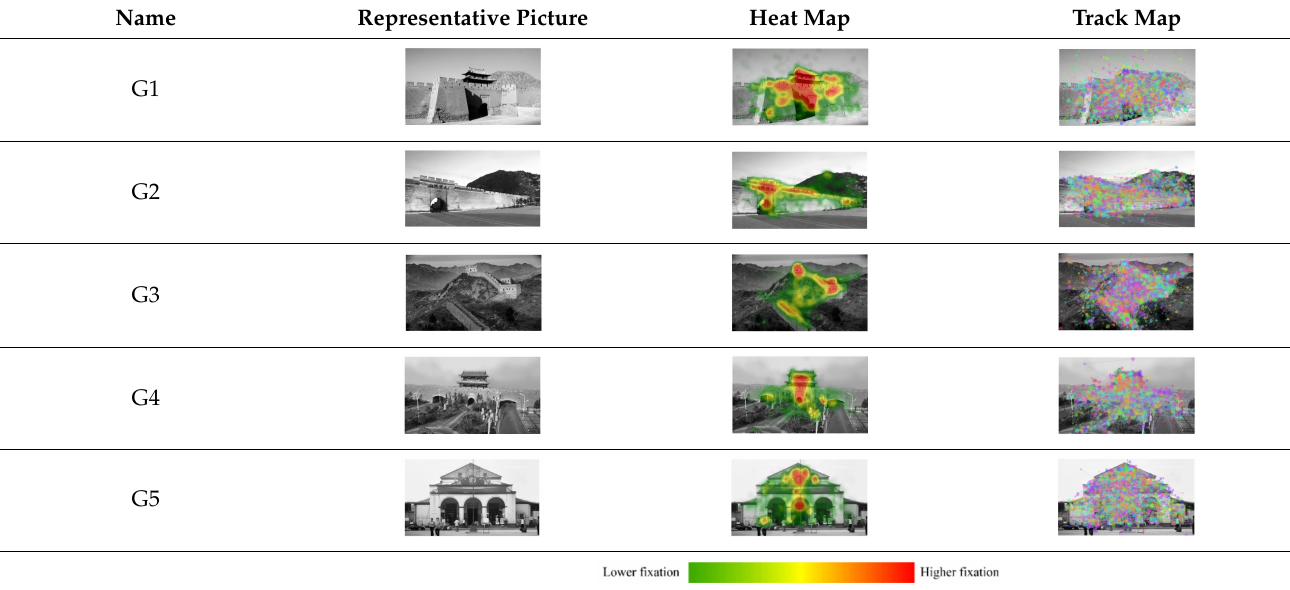
Table 5. Visualization Results from Representative Pictures.